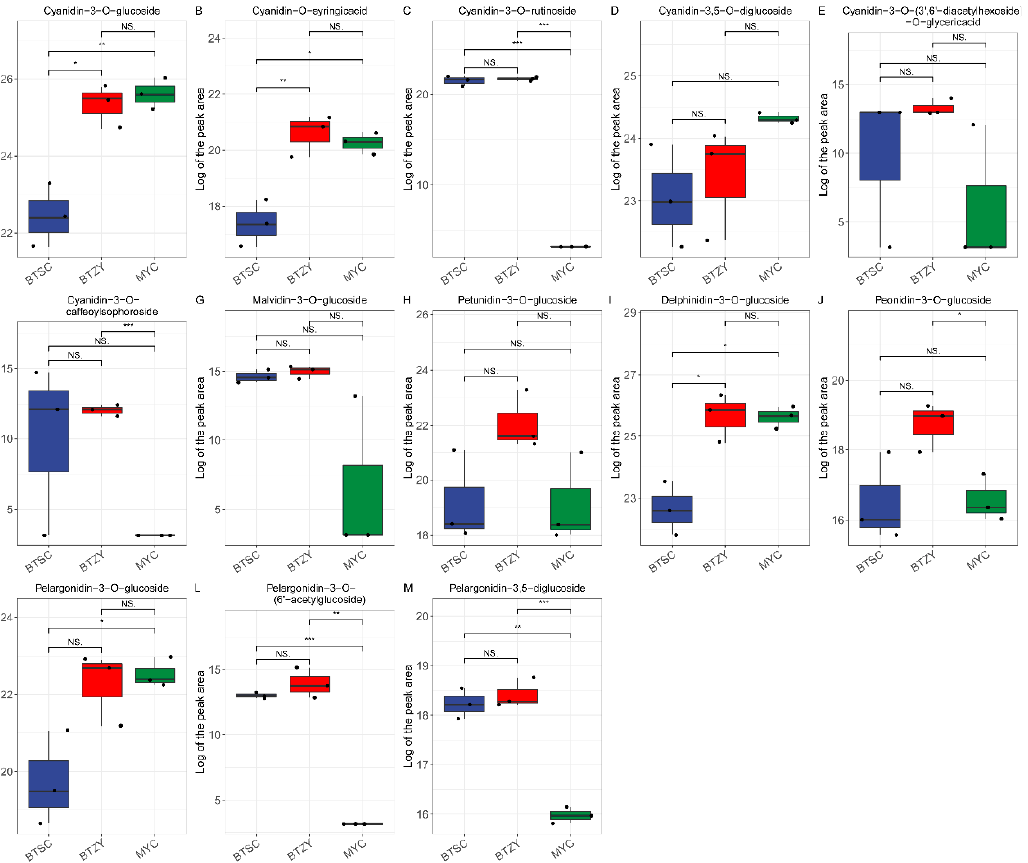
Figure 2. The differentially accumulated anthocyanins identified in this study. Differences between mean values of groups were compared using t -tests (“*”: p < 0.05; “**”: p < 0.01; “***”: p < 0.001; NS.: p > 0.05). ( A – H ) the value of logarithm (Log) of peak areas of different metabolites. The black circle refers to the value from various